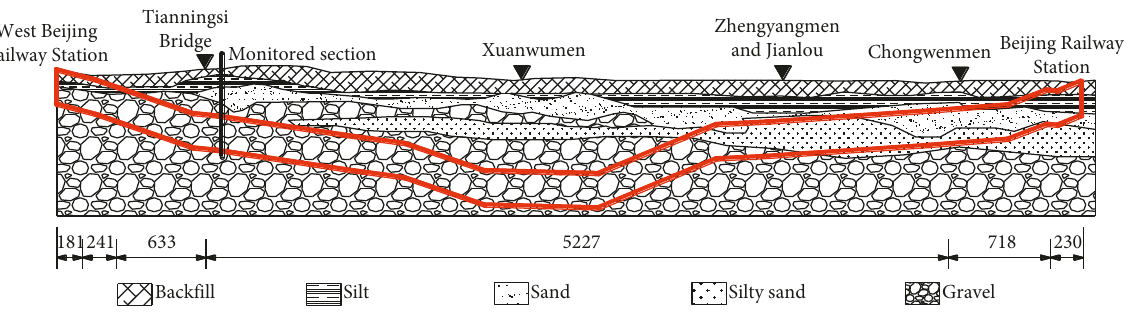
Figure 2: Geological profile of the project (unit: m).